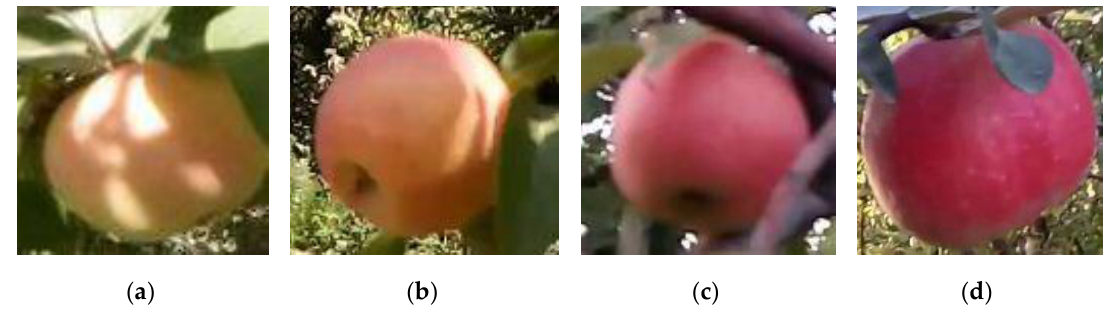
Figure 2. Sample images of the four different apple ripening stages ( Malus Domestica L., var. Red Delicious) extracted from the captured frames under natural lighting conditions. ( a ) Unripe. ( b ) Half-ripe. ( c ) Ripe. ( d ) Overripe.